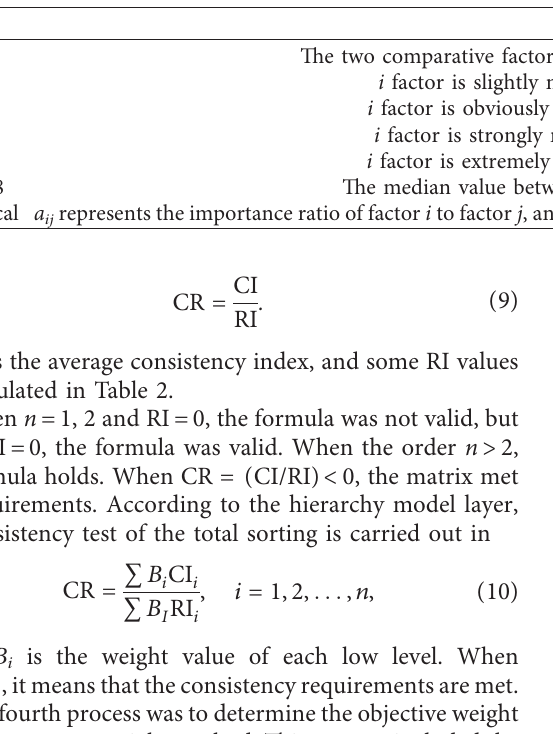
Table 1: Scale values used in the judgment matrix of the